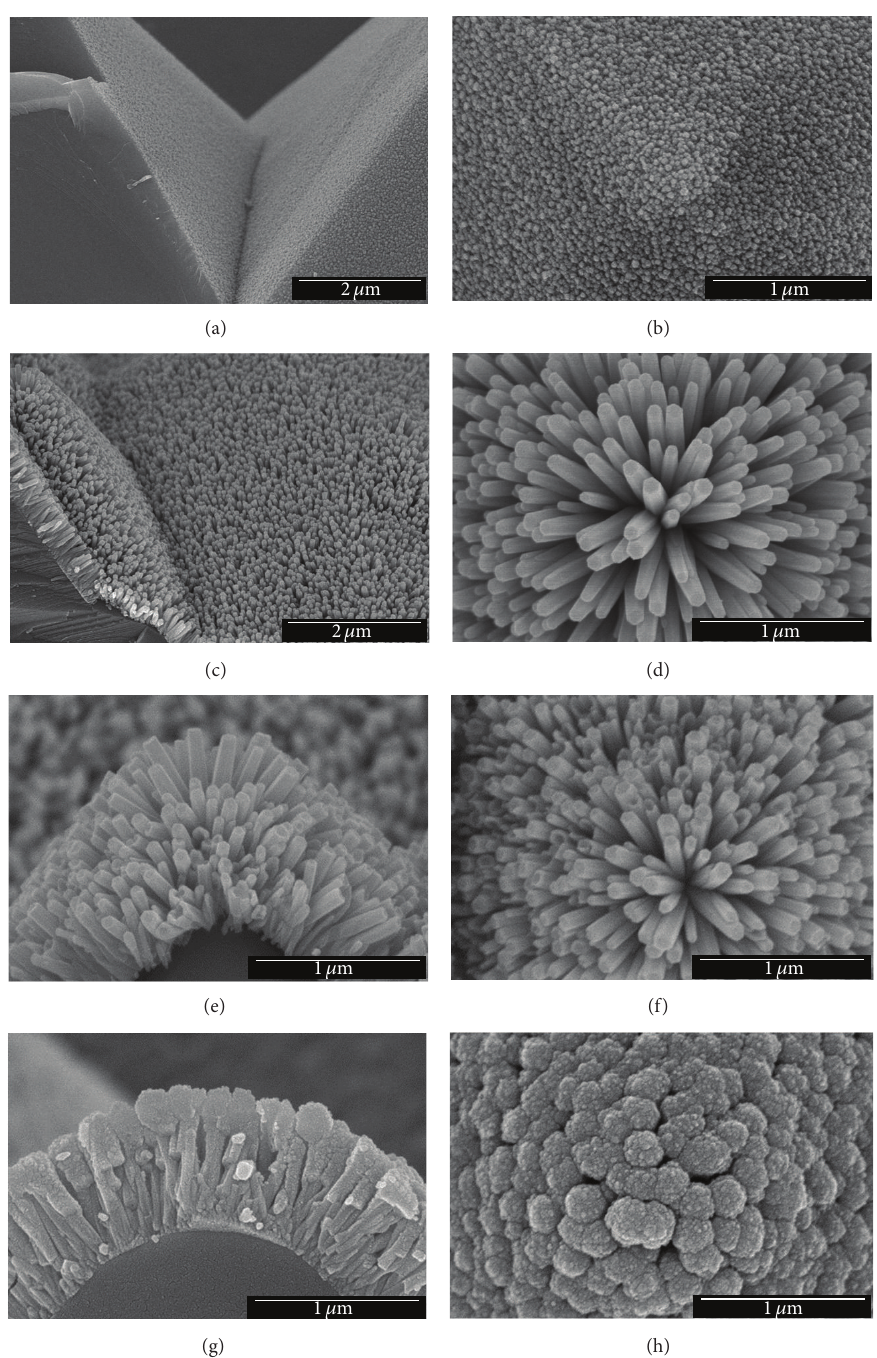
Figure 3: SEM images of surface morphology of prepared SCs. (a) Tilted- and (b) top-view images of regular SC, (c) tilted- and (d) top-view images of SC-C, (e) tilted- and (f) top-view images of SC-B, and (g) tilted- and (h) top-view images of